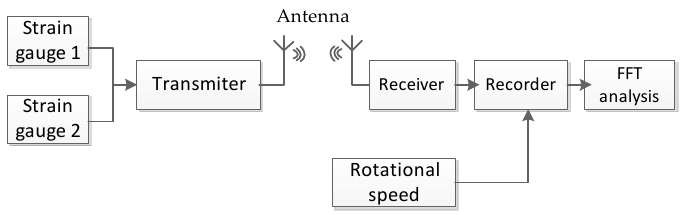
Figure 8. Block scheme of the telemetry system for strain gauge tests.